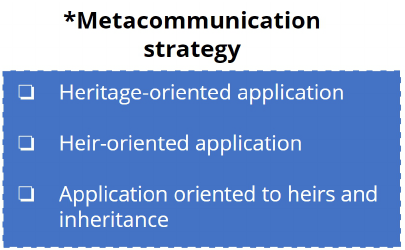
Fig. 8. Metacommunication strategies that represent the focus of the digital assets management in the